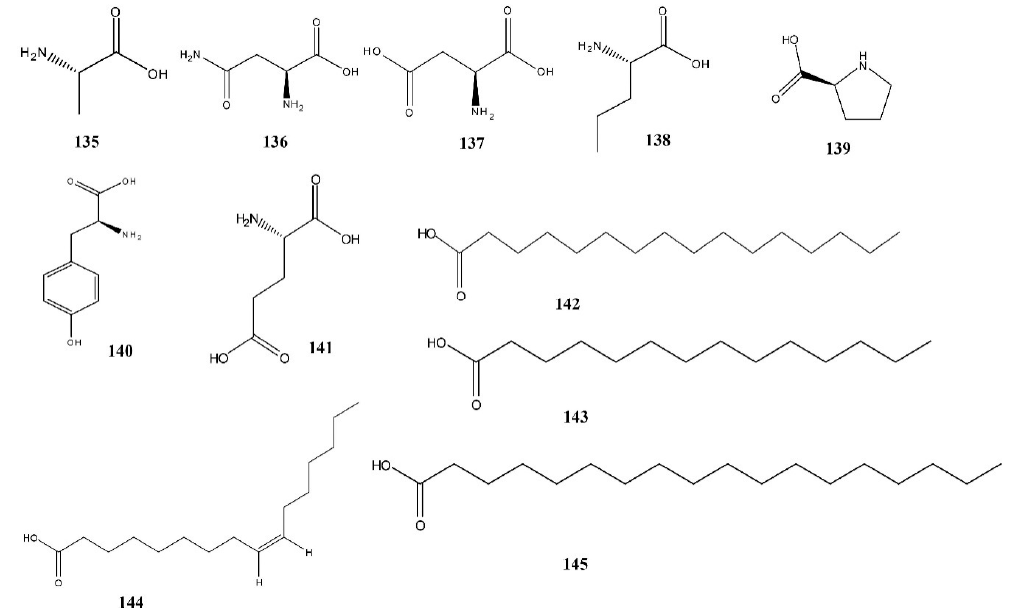
Figure 5. Chemical structures of isolated compounds from A. calamus.